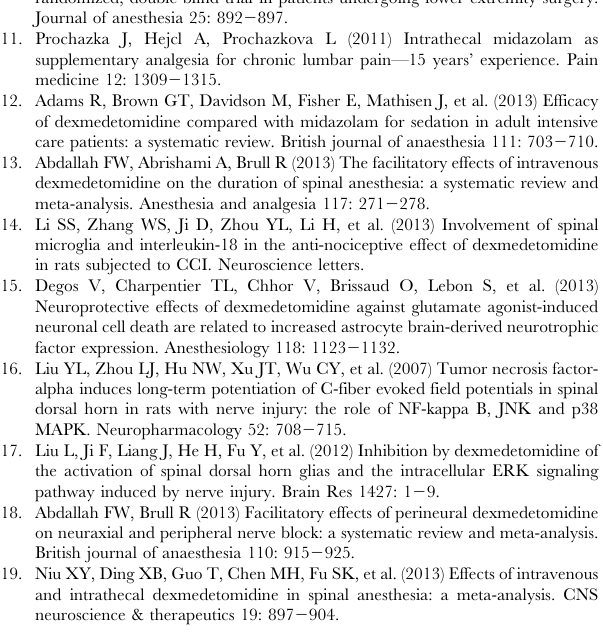
Figure S1 Sensitivity analysis. A: postoperative pain inten- sity, B: postoperative analgesic duration, C: bradycardia, and D: hypotension. (TIF) Figure S2 Begg’s funnel plot. A: postoperative pain intensity, B: postoperative analgesic duration, C: bradycardia, and D: hypotension. Table S1 Main study characteristics. Table S2 Risk of bias for each included study. Table S3 Egger’s test of primary